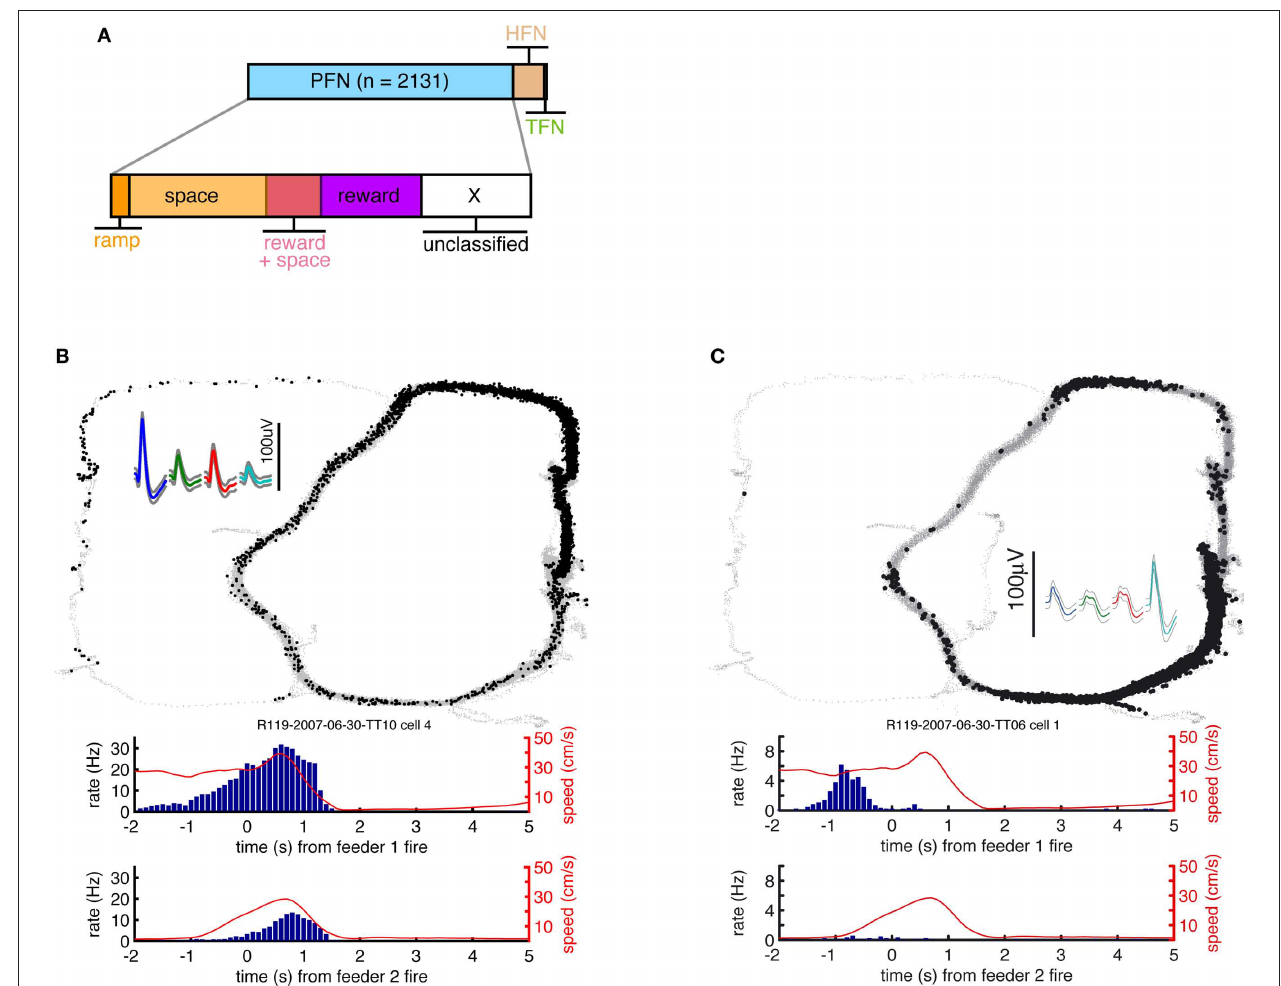
average waveforms on the 4 tetrode channels. The lower panels show peri- event time histograms (blue bars), where time 0 is pellet release time (“feeder fi re”) for feeder 1 (F1, top) and feeder 2 (F2, bottom), as well as the animal’s speed (red line). Note how although time 0 is the time of pellet release (triggered when the animals crossed the green lines in Figure 1A ), pellets only reached the track about 1.5–2 s after this time. (C) Typical example of a cell with spatial fi ring fi elds. Unlike primary neurons in hippocampus (“place cells”) ventral striatal cells rarely exhibited single, well defi ned fi ring fi